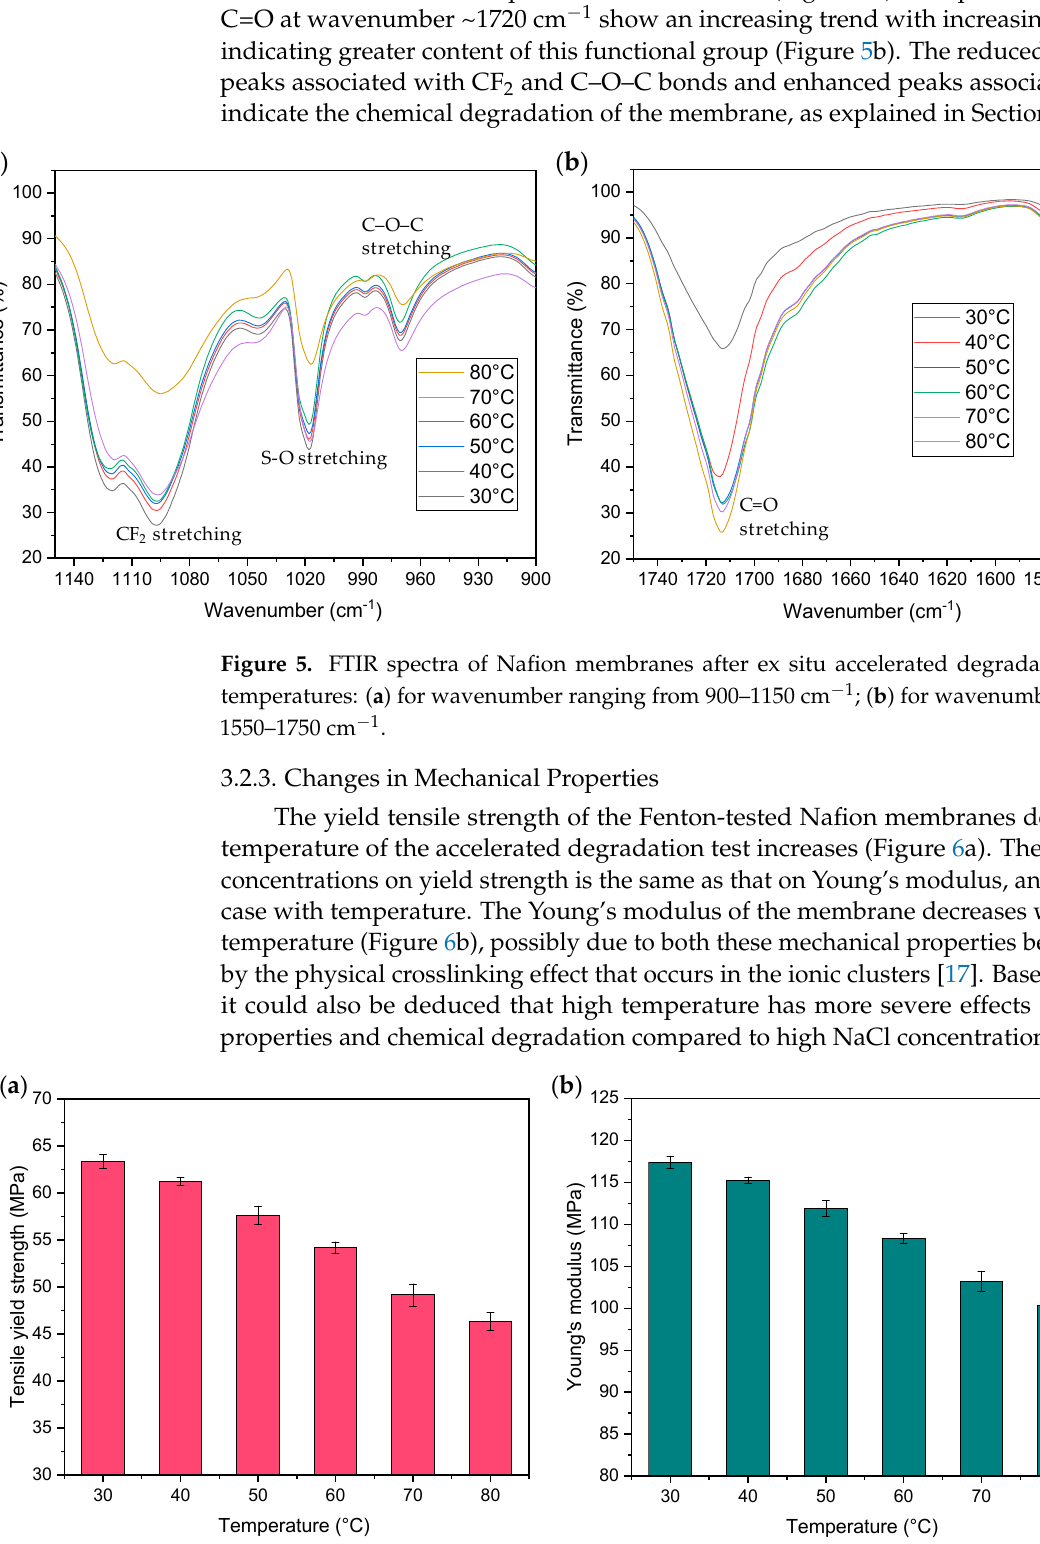
Figure 6. Mechanical properties of the membrane after ex situ degradation test with Fenton’s reagent: ( a ) tensile yield strength (MPa) of membranes at di ff erent temperatures; ( b ) Young’s modulus (MPa) of membranes tested at di ff erent temperatures.